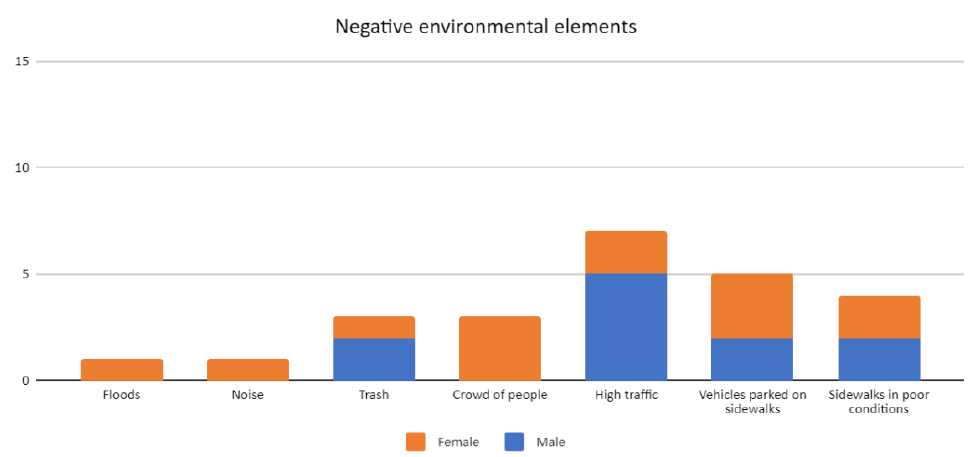
Figure 6. Negative environmental elements mentioned during walking interviews in Barrios Bajos, Valdivia. Source: Authors.